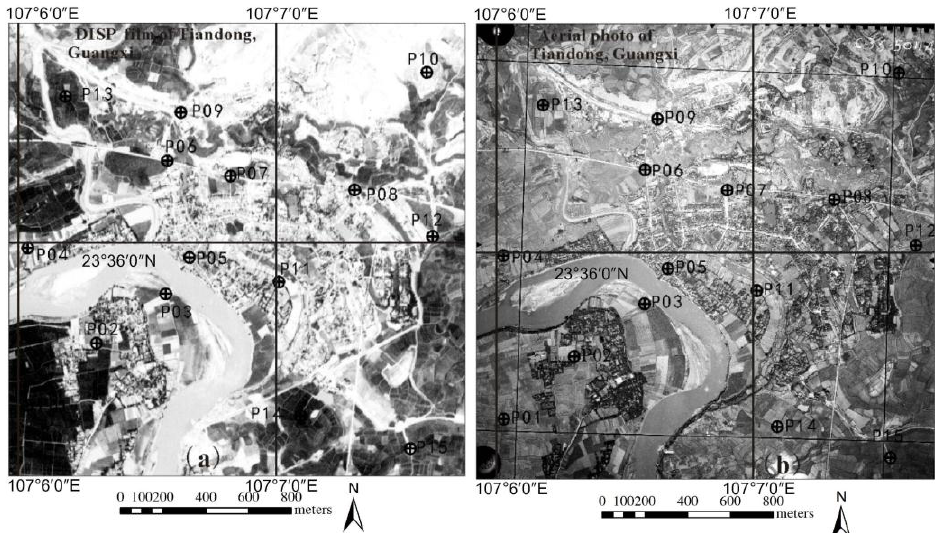
Figure 8. Accuracy verification using orthorectified aerial photos from 1961: ( a ) DISP image orthorectified using the proposed method; and ( b ) orthorectified aerial photo from 1961.